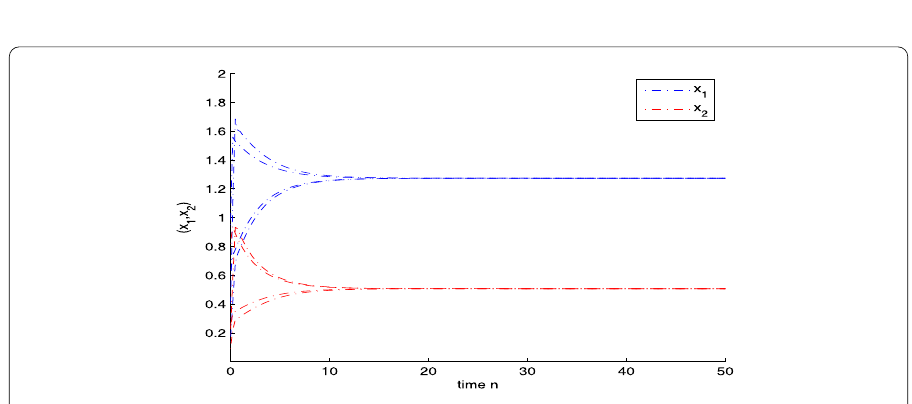
Figure 8 Numeric simulations of system (4.4) with the initial conditions ( x (0), y (0)) = (0.14,0.19),(0.37,0.009),(0.95,0.024), and